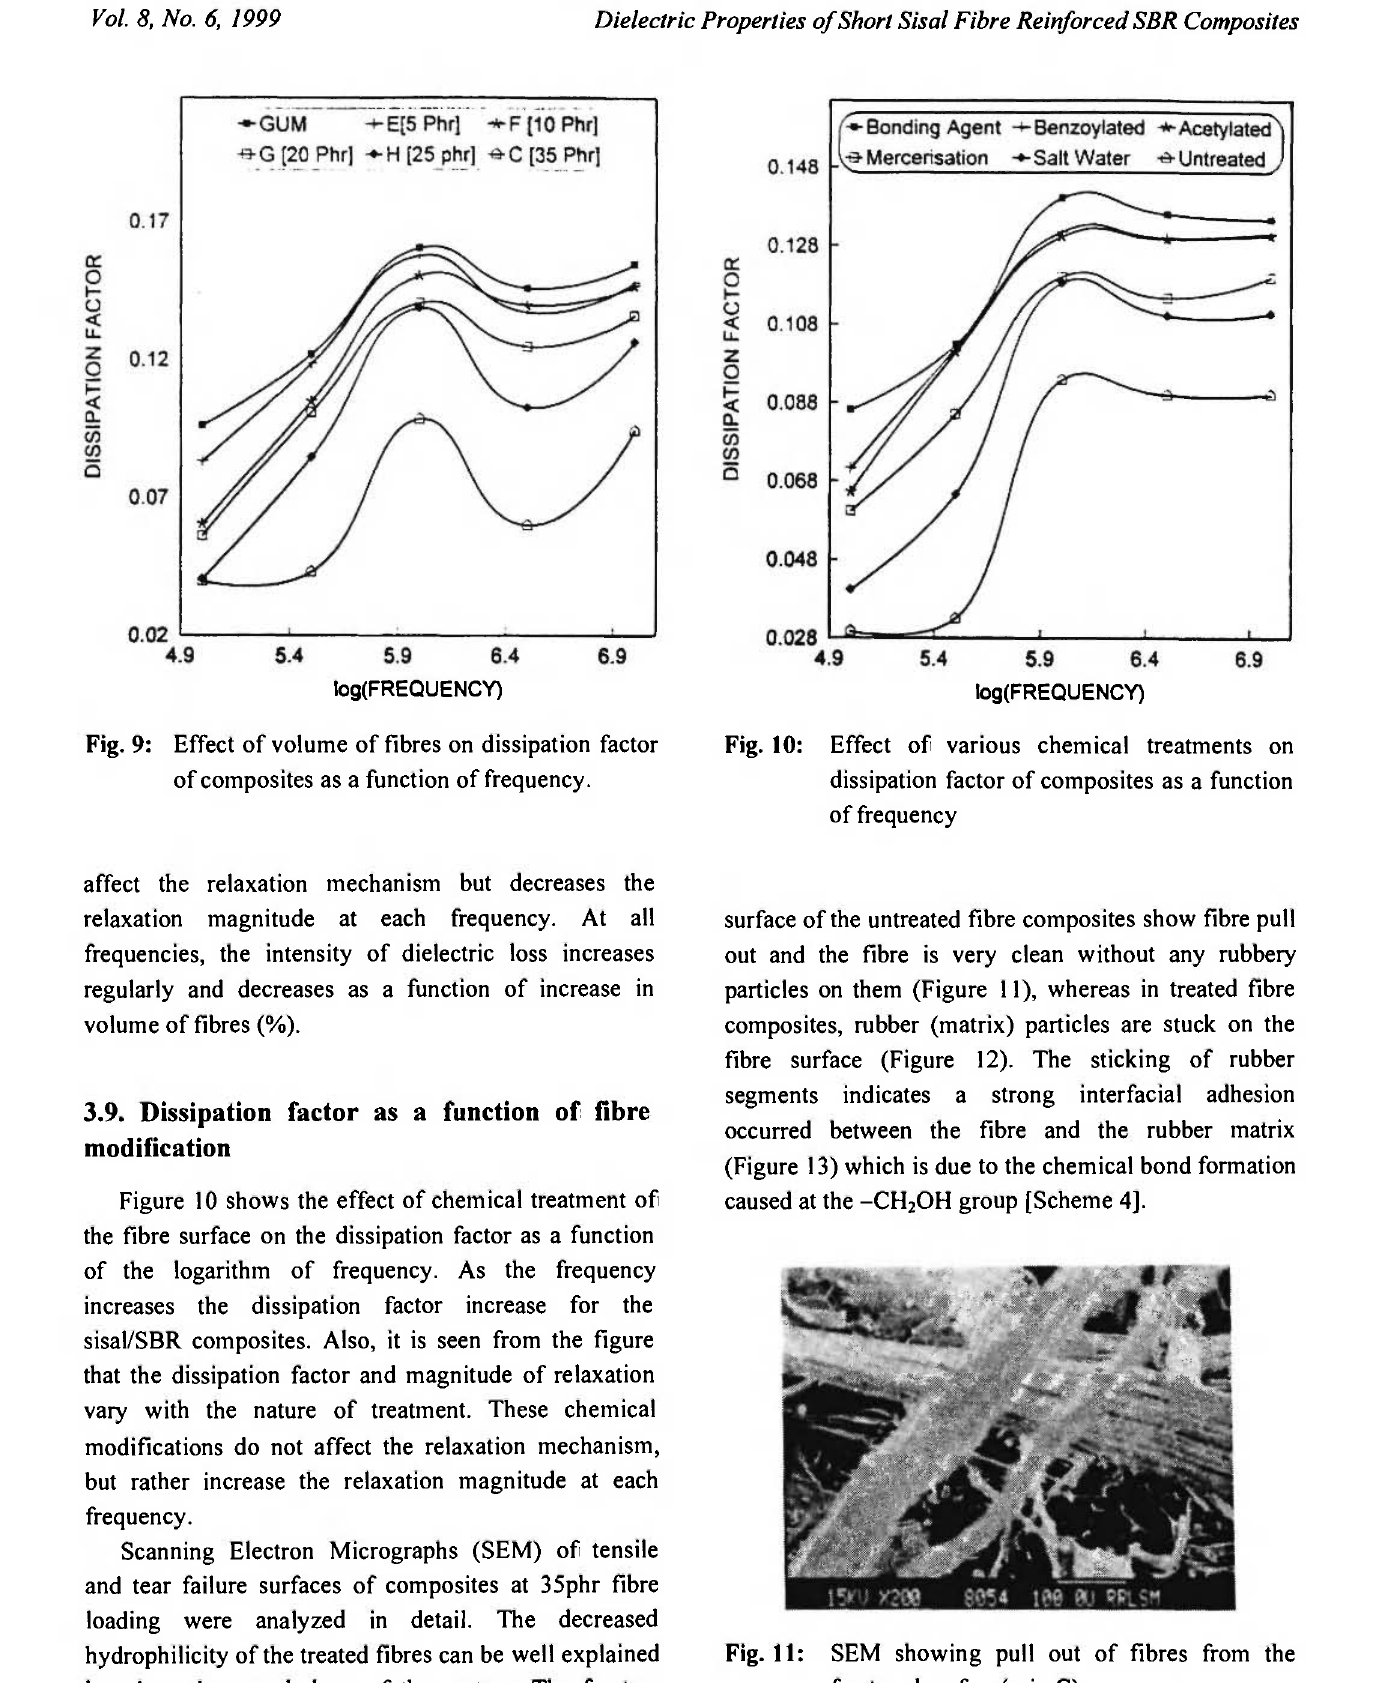
Fig. 11: SEM showing pull out of fibres from the fractured surface(mix